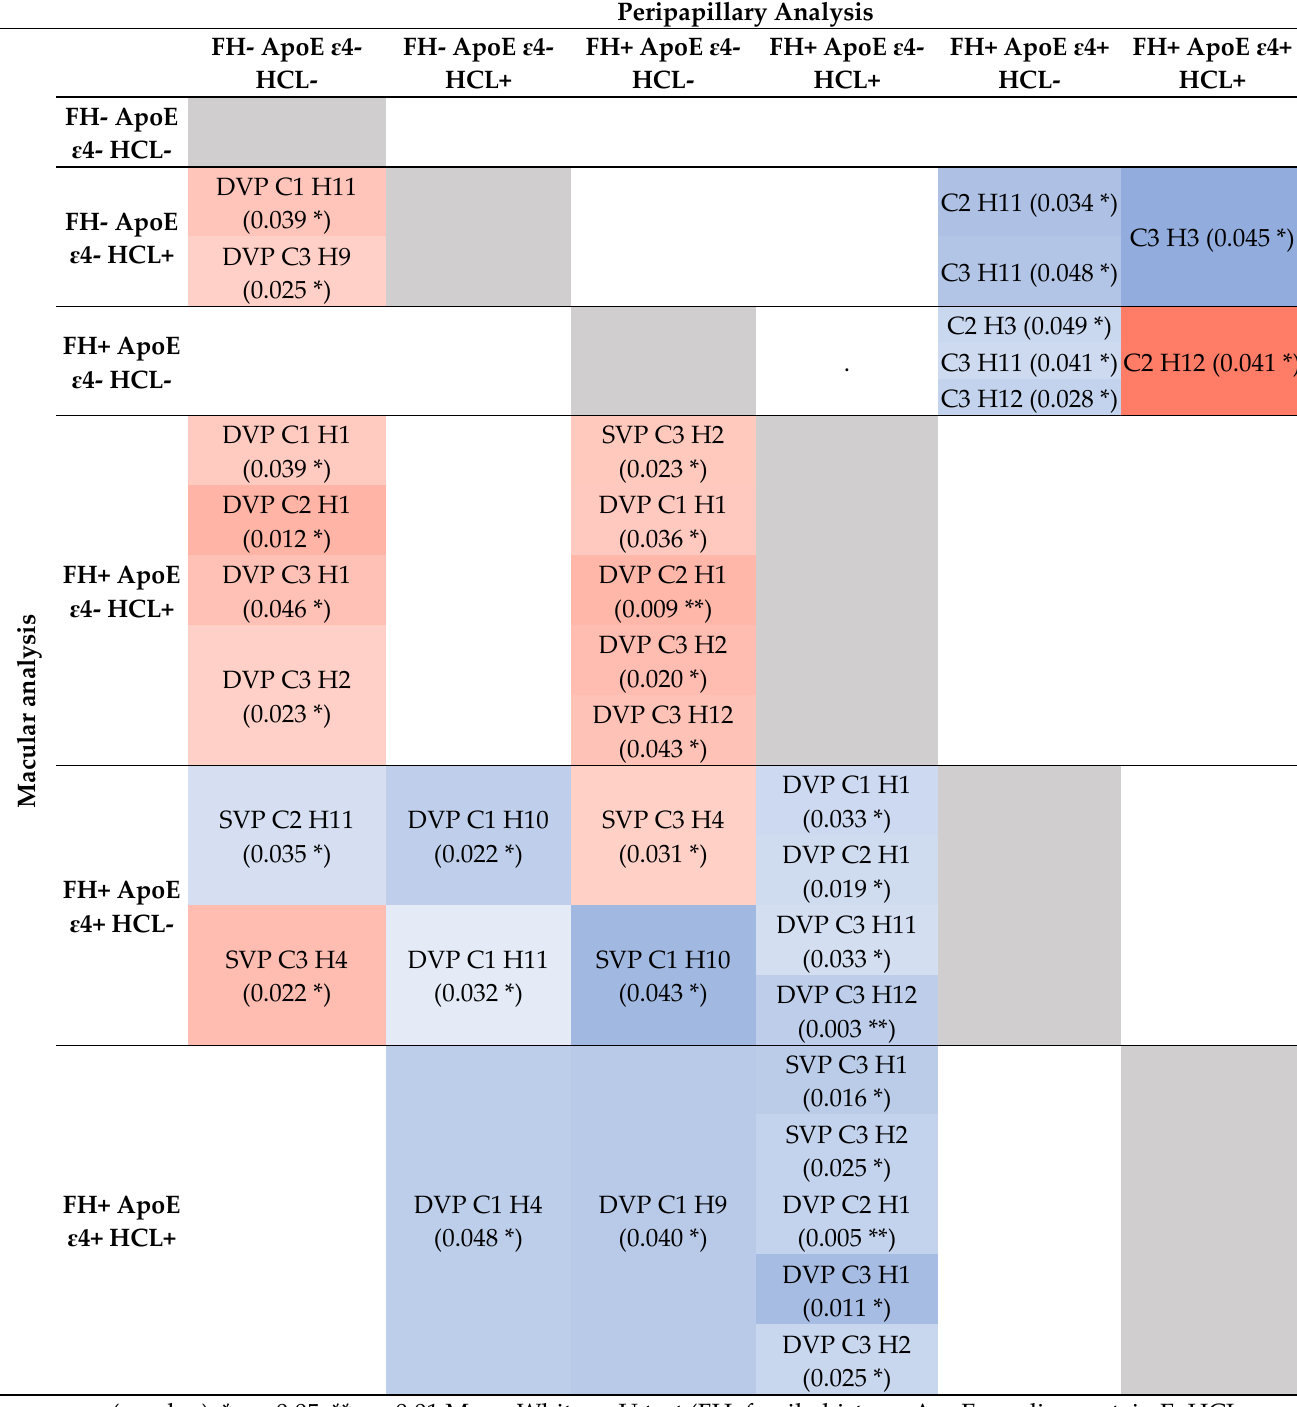
Table 2. The p values of the macular vascular densities of the subjects classified by family history and the allelic characterization of ApoE E 4 and HCL using the EA-Tool.